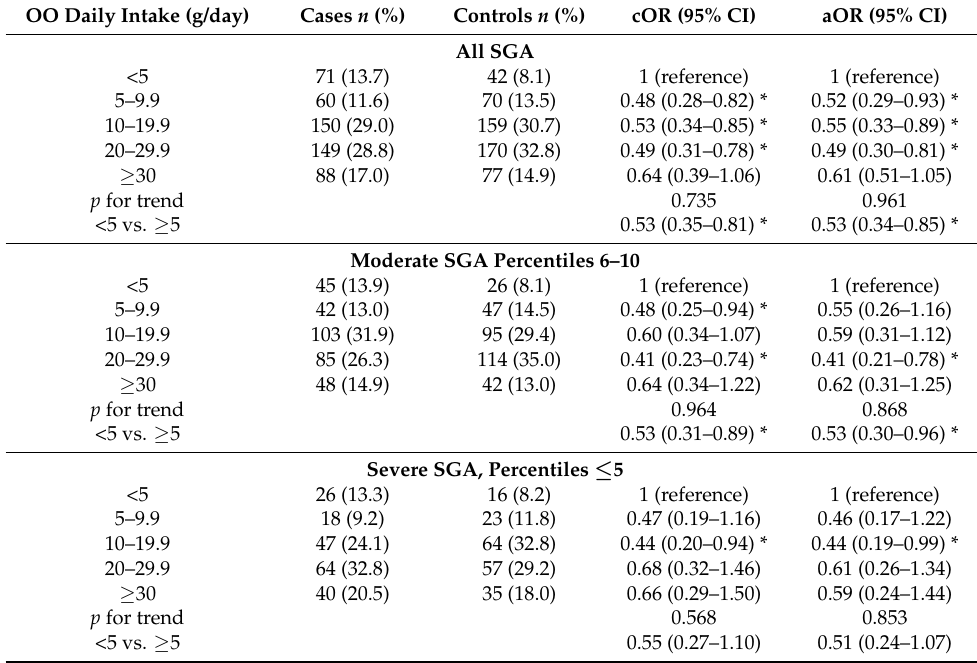
Table 5. Daily intake (g/day) of olive oil (OO) and risk of SGA for entire sample and stratified on degree of